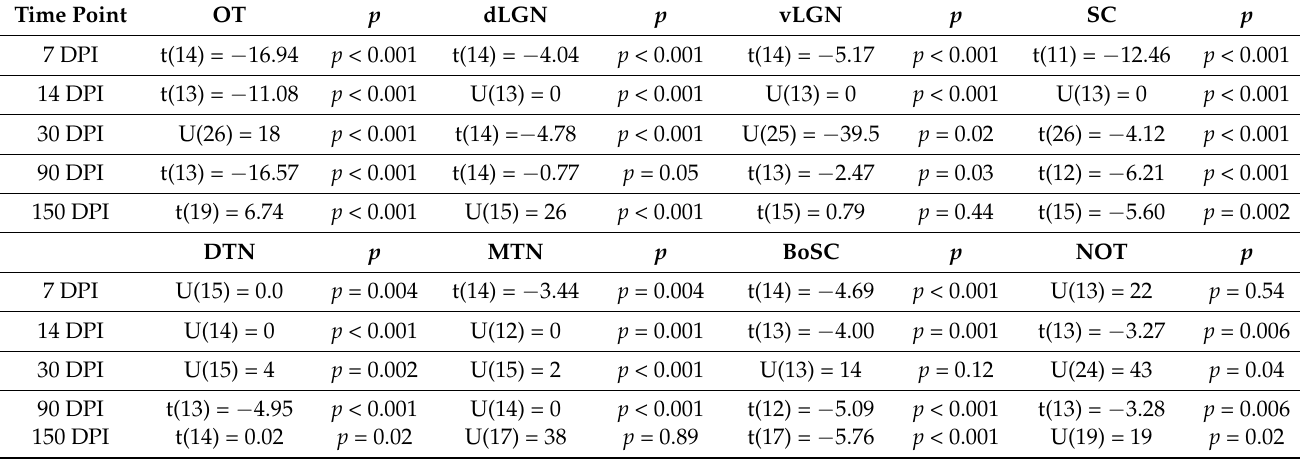
Table 2. Statistics for IHC—Fluoro Jade-C.